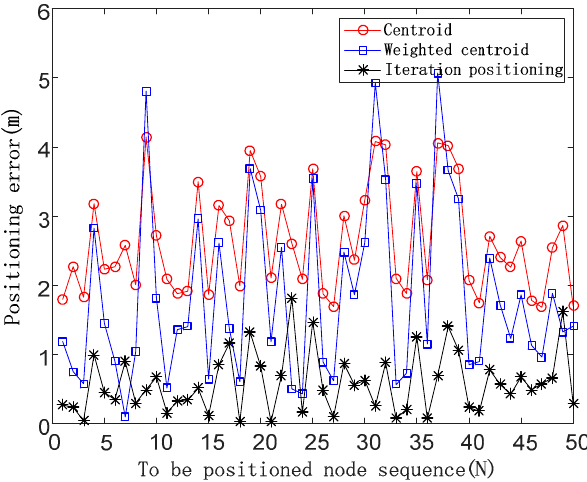
Figure 8. Positioning errors of three positioning algorithms in the case of the noise impact factor of 0.3.